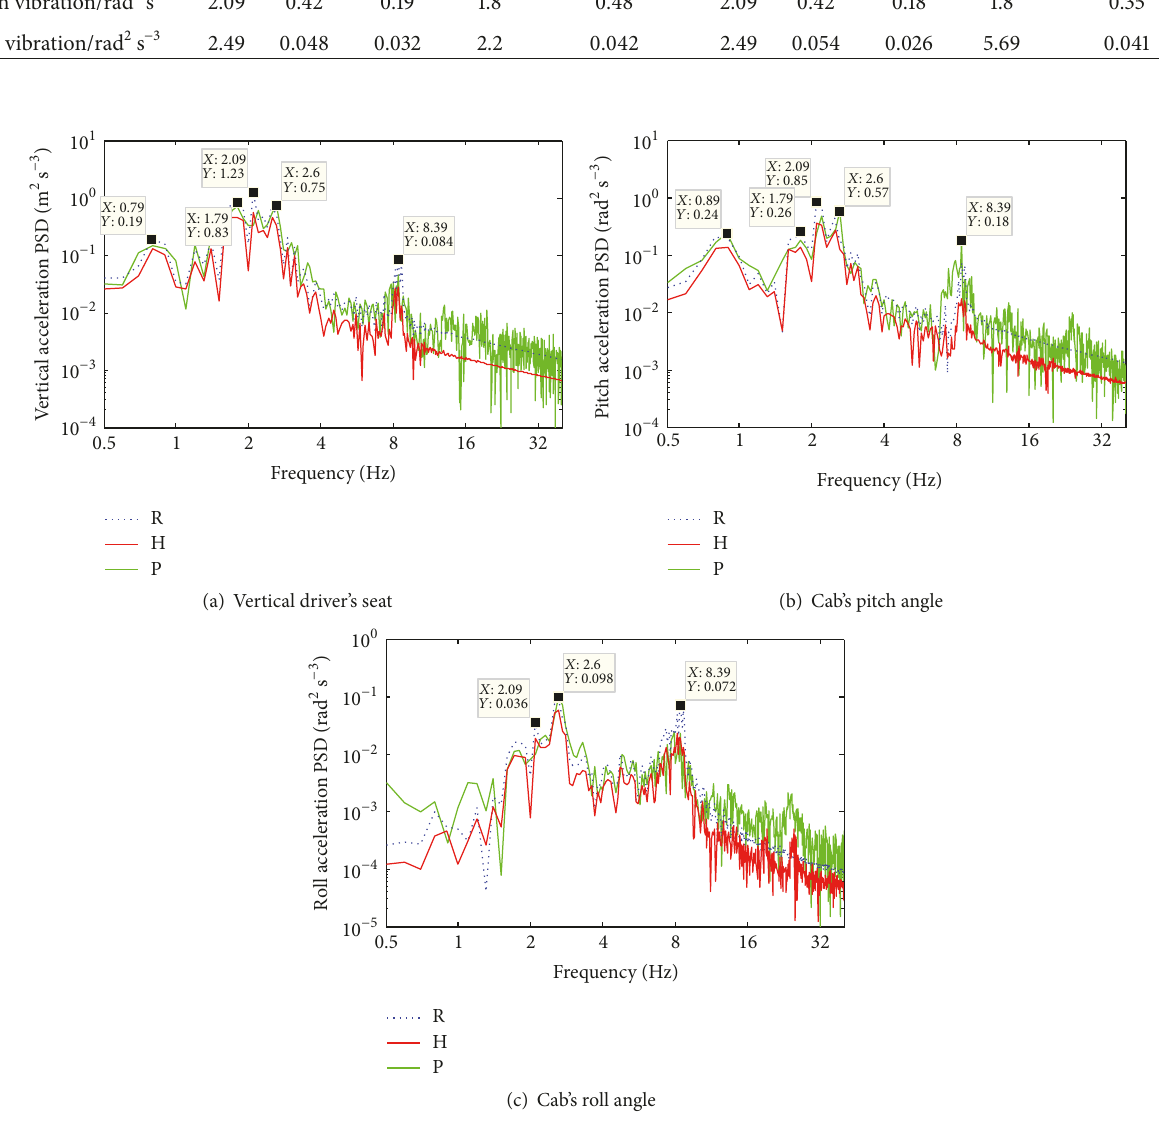
Figure 10: The acceleration PSD responses under an excitation of the off-road terrain of Grenville